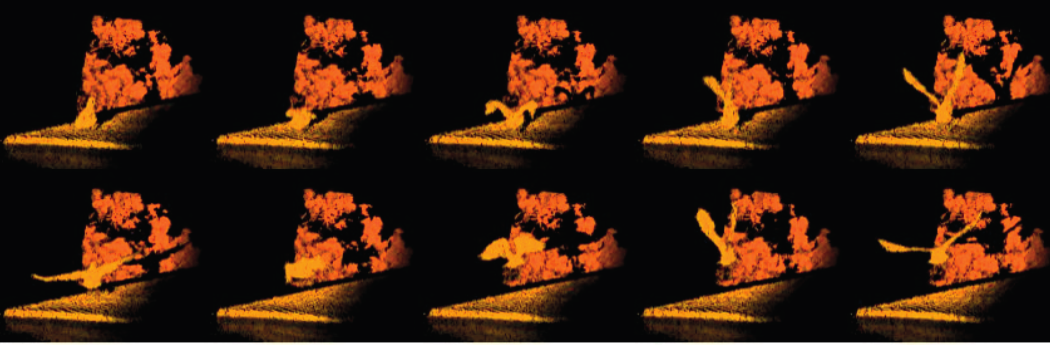
Figure 4. A seagull is taking off from a